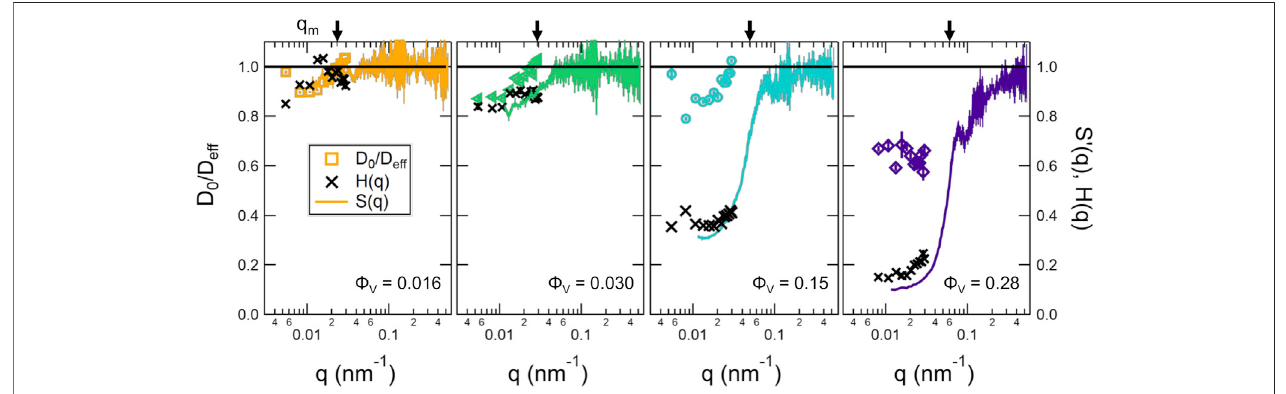
FIGURE 4 | D 0 / D eff determined from DLS measurements, S ′ ( q ) determined from SANS measurements, and extracted H ( q ) values from the combined DLS and SANS results calculated as H ( q ) = S ′ ( q ) D eff / D 0 for different volume fractions of vesicles ( ϕ V ) listed on the plots. The vertical arrow on the upper x -axis show the